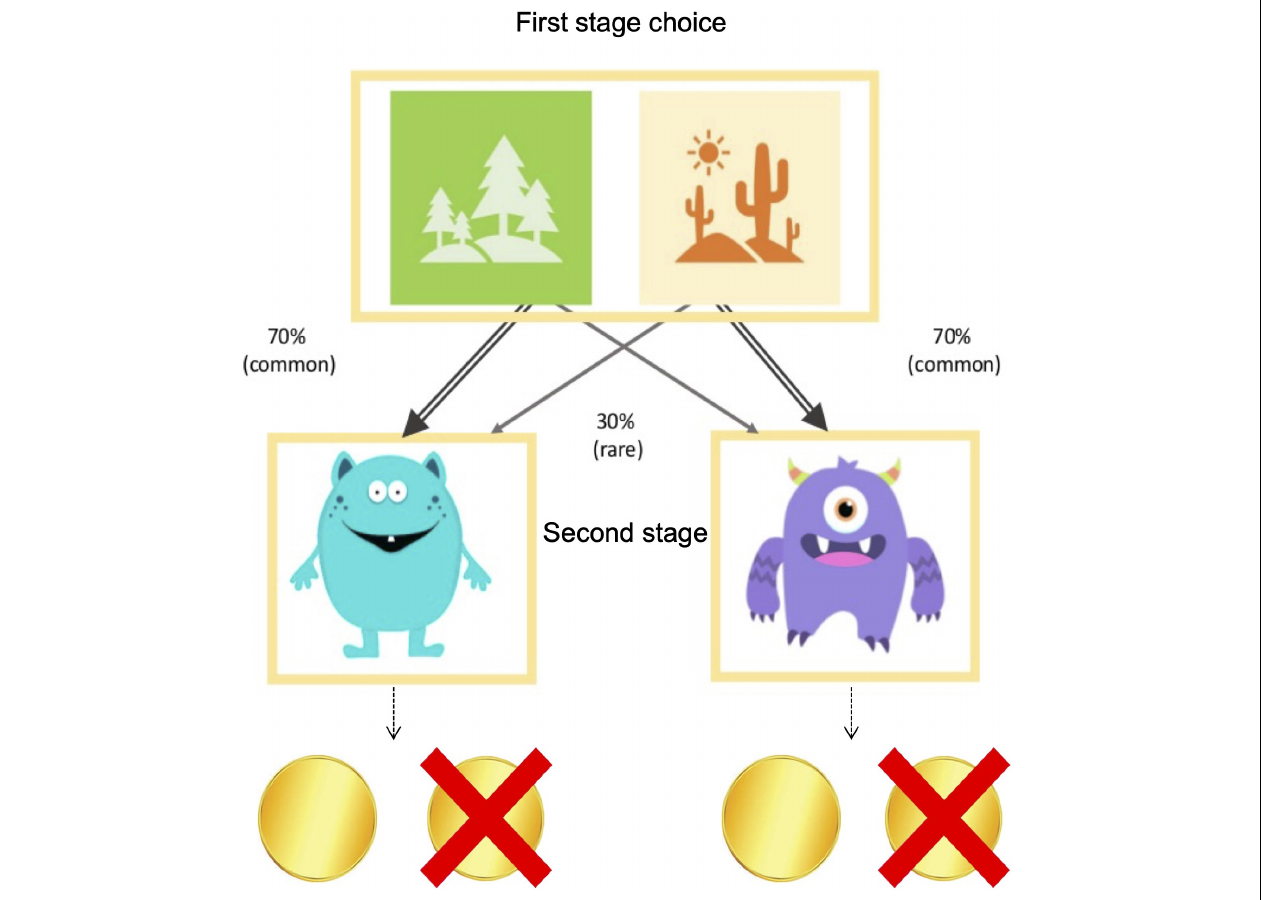
FIGURE 1 | Two-stage Markov Decision Task. Participants were given a choice between one of two start states on each trial, a forest and a desert. One location more commonly (70%) led to one of the second-stage states (the blue and purple cartoons), and rarely (30%) led to the other. Each second-stage state was associated with slowly changing reward